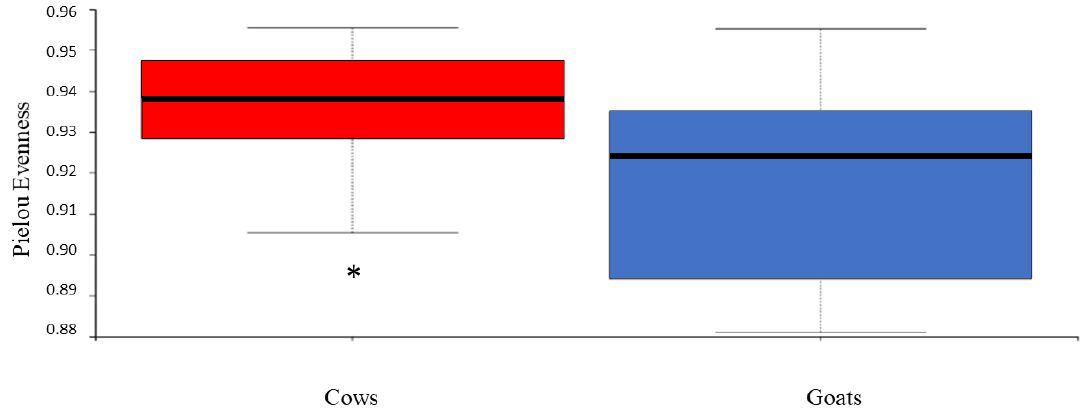
Figure 1. Boxplot of evenness values (Pielou’s index) for 16S rRNA gene sequences retrieved from the feces of cows and goats. * indicates a significant difference ( p < 0.05).